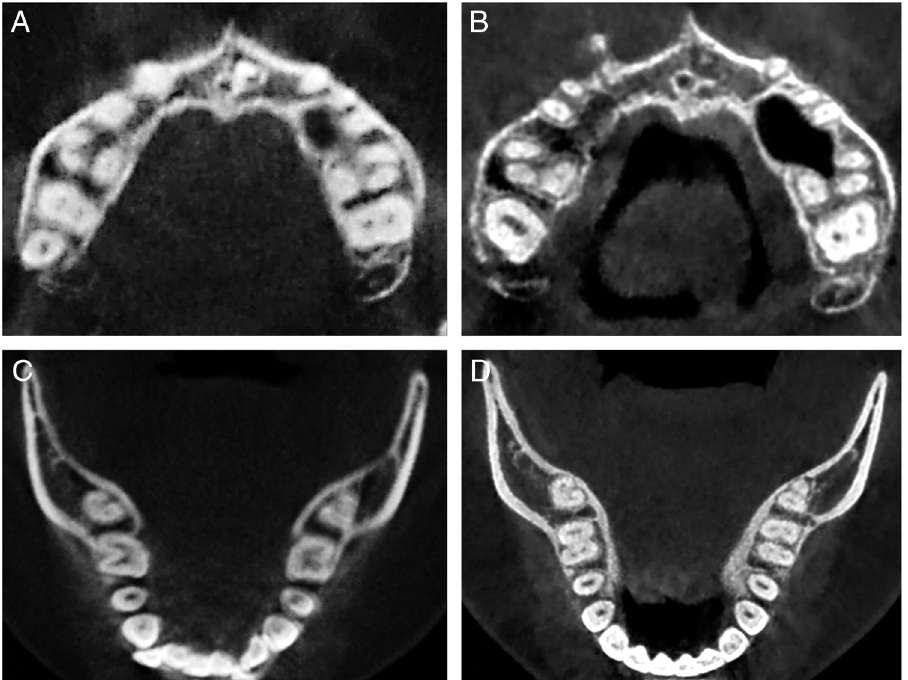
Figure 7. Posterior available space: (A) Pre-treatment of the manxilla (presence of the maxillary right third molar); (B) Post-treatment of the maxilla; (C) Pre-treatment of the mandible; (D) Post-treatment of the mandible.